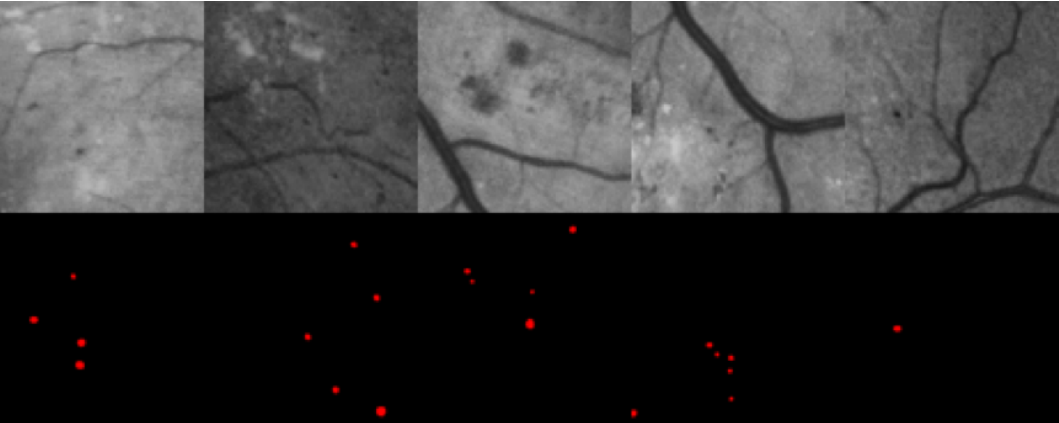
Figure 2. Construction of IDRiD_VOC using the sliding window method. The equalized images and segmentation maps were both sliced. After slicing, some useless image blocks and the corresponding segmentation map blocks were discarded, such as corner patches containing no meaningful information.